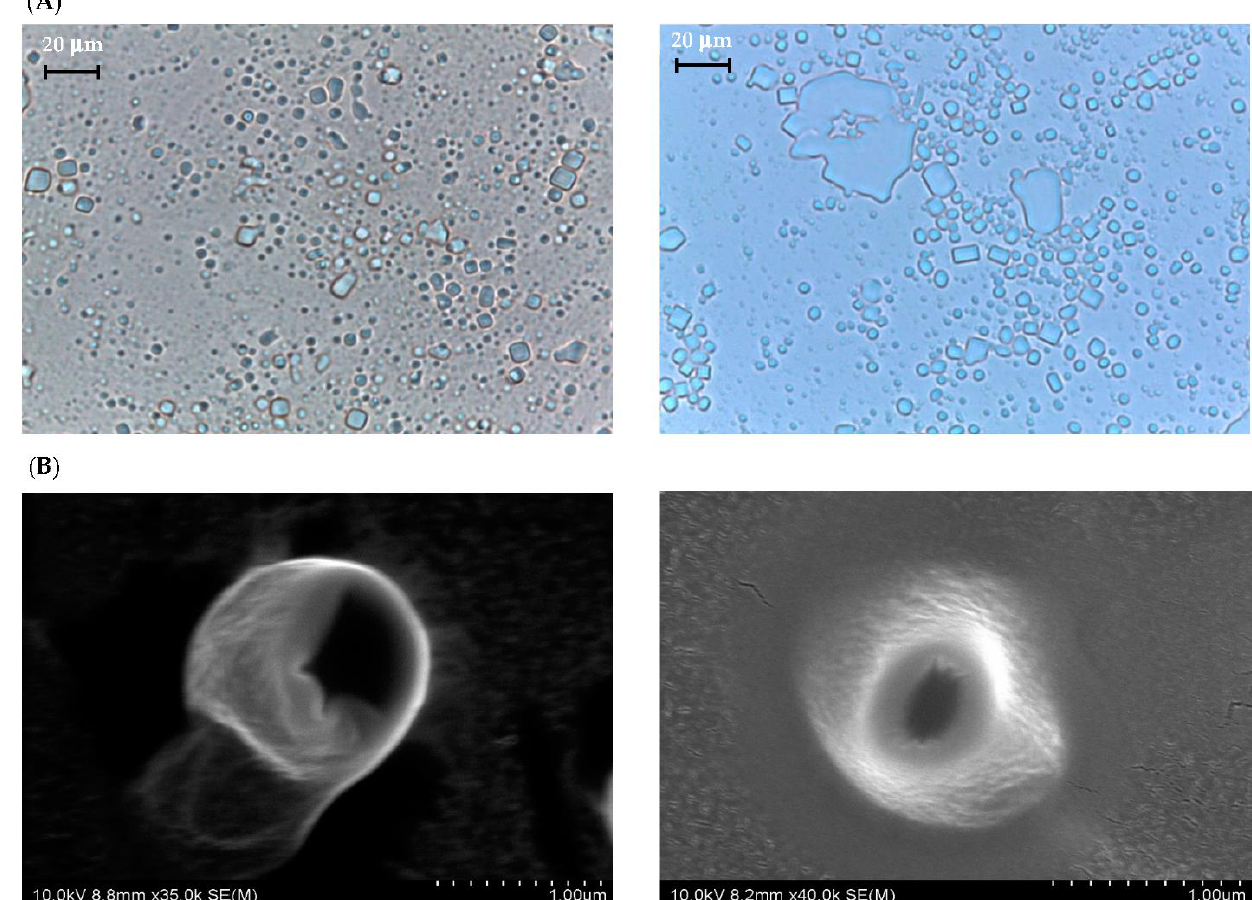
Figure 1. ( A ) PLM and ( B ) SEM micrographs of CUB ( left ) and CUBTAM ( right ). For particle size distribution, CUBTAM had a unimodal curve and its polydispersity index (PDI) was quite small (below 0.3), as shown in Figure S1. The mean hydrodynamic diameter of liquid crystal particles increased significantly (from 270 to 327 nm) with the addition of the tamarillo extract. In general, this parameter depends on several factors such as the concentration of amphiphile (lipid and polymer), the presence of charged li- pids, the ionic strength and the interactions between groups [23]. For CUBTAM, the ad- dition of hydrophilic groups contributed to increasing electrostatic interaction as well as the coalescence between colloidal particles resulting in a bigger average particle size. However, most of the cubic particles in CUBTAM were still limited to a sub-micron range (100 – 1000 nm). According to Danaei et al. [29] the small particle size and the narrow size distribution (small PDI) create a large surface area that benefits cellular uptake. Entrapment efficiency (EE%) of bioactive compounds from CUBTAM ranged from 19.8 (catechin) to 87.7% kaempferol rutinoside (Figure 2). Twelve of the fourteen tamarillo bioactive compounds had an EE of more than 50%. In addition, it is noteworthy that we show high EE% (>69%) for the major polyphenols in tamarillo (chlorogenic acid, kaempferol rutinoside, delphinidin rutinoside, cyanidin rutinoside and pelargonidin ru- tinoside). The high EE in the CUBTAM could be attributed to the fact that polyphenols in tamarillo extract are water-soluble compounds which embed in the water channels. The EE difference between polyphenols encapsulated by cubosome might also depend on the number of -OH groups in molecular structure. For example, the hydroxycinnamic acids chlorogenic acid, caffeic acid and ferulic acid (with >2 -OH groups) showed higher EE than p-coumaric acid (which has only 1 -OH group). More -OH groups will more easily